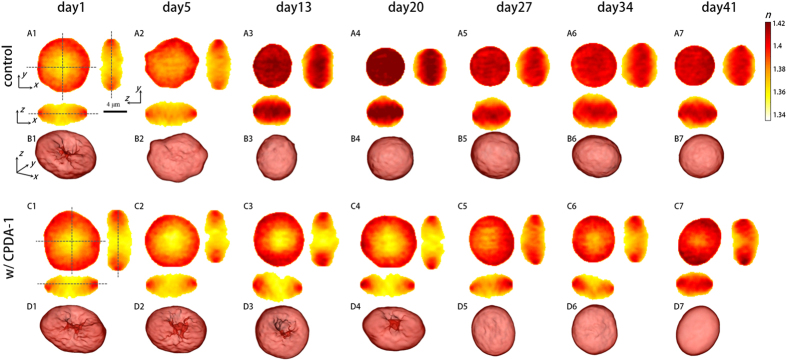
Cross-sectional slices of reconstructed RI tomograms of stored RBCs without CPDA-1 as the control (A1–A7) and with CPDA-1 (C1–C7) at days 1, 5, 13, 20, 27, 34, and 41 of the storage period, respectively, in the x-y (left), y-z (right), and x-z (below) plane (B1–B7 and D1–D7).Corresponding rendered isosurfaces of 3-D RI maps for the control and CPDA-1, respectively (n > 1.360).